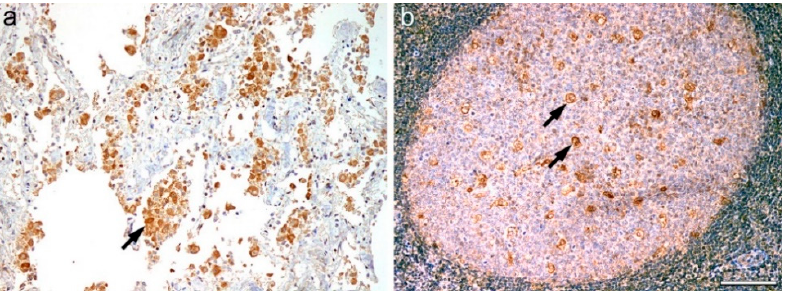
Figure 3. ( a ) SOAT1 expression in alveolar macrophages of lung tissue and ( b ) in the germinal center histiocytes of tonsillar tissue (scale bar 200 µm).